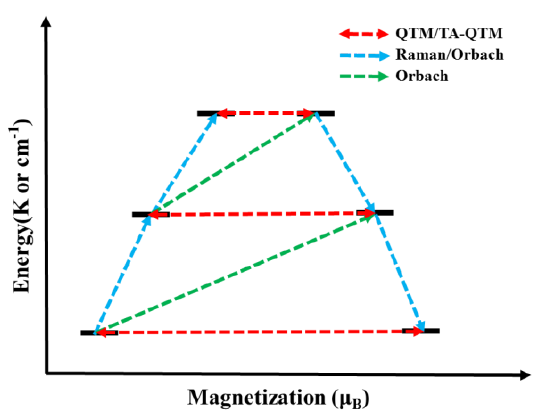
Figure 1. All of the possible magnetic relaxation paths in rare-earth SMMs. CASSCF is one of the central methods in dealing with metal complexes, successful at possessing the static correlation of multibody wave functions through fine zeroth-order wavefunction. Three varieties of orbitals are segregated from the whole orbitals in molecule systems, such as closed space, active space and virtual space (Figure 2). In this method, dynamic correlation is not originally fully taken into account, while the complete active space perturbation theory (CASPT2) [36–38], N-electron valence state perturbation theory (NEVPT2) [39,40] and multi-reference configuration interaction method (MRCI) [41,42] can realize the approximation of the full configuration interaction (CI) to recover dynamic correlation effect and acquire relatively pinpoint parameters. It is noted that the pivot of this approach in actual calculation processes is to determine appropriate and